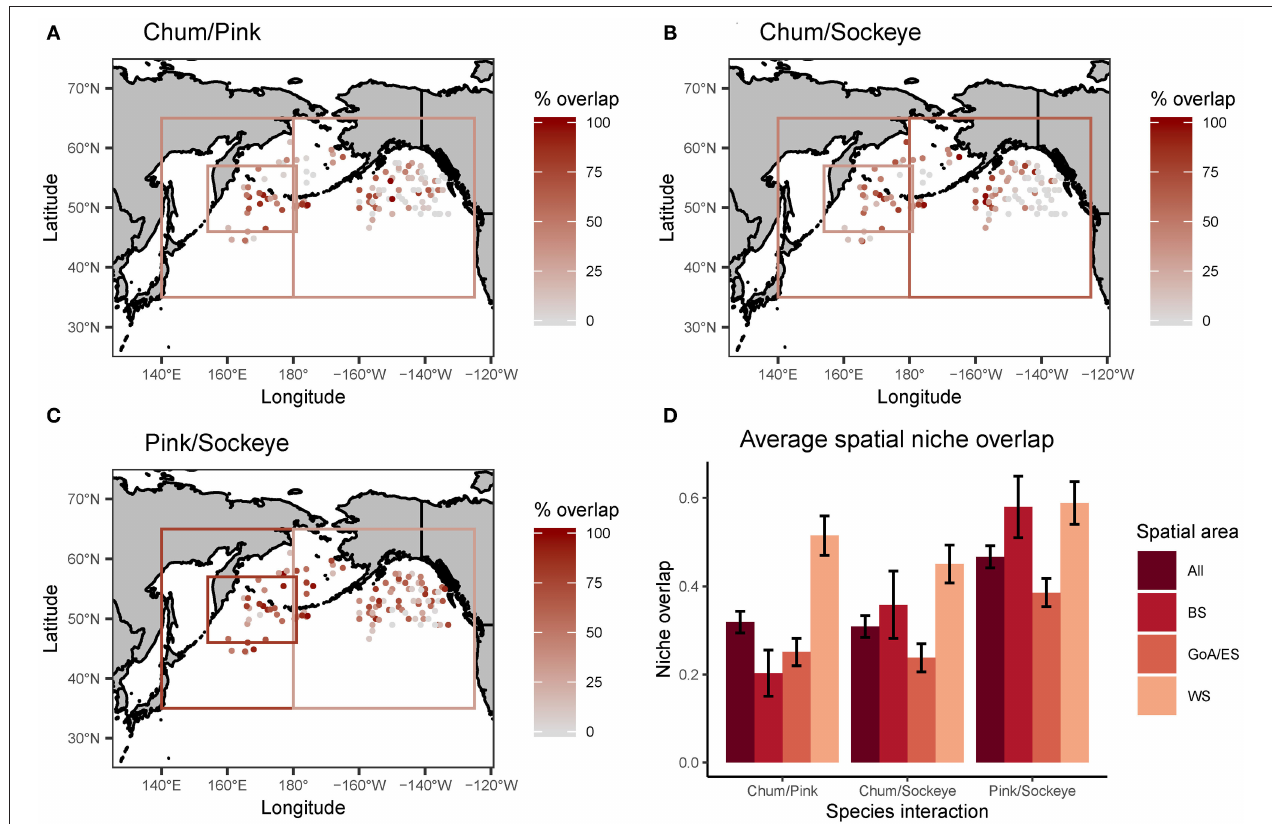
FIGURE 5 | A spatial map of trophic niche overlap, measured using Schoener’s index of niche overlap, for (A) chum/pink, (B) chum/sockeye and (C) pink/sockeye calculated for each site where chum, sockeye and pink were collected together at the same time. Additionally, the average spatial niche overlap for the entire North Pacific (All) and broken down by three regions (BS, Bering Sea; GoA/ES, Gulf of Alaska/Eastern Subarctic; WS, Western Subarctic) are displayed with standard error bars (D) . The boxes on the maps in (A–C) represent data reported for an area, as opposed to precise spatial